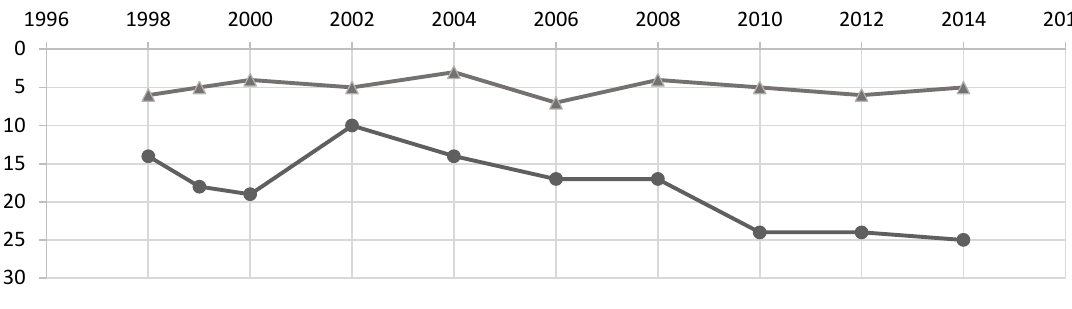
Figure 4. Usage and satisfaction